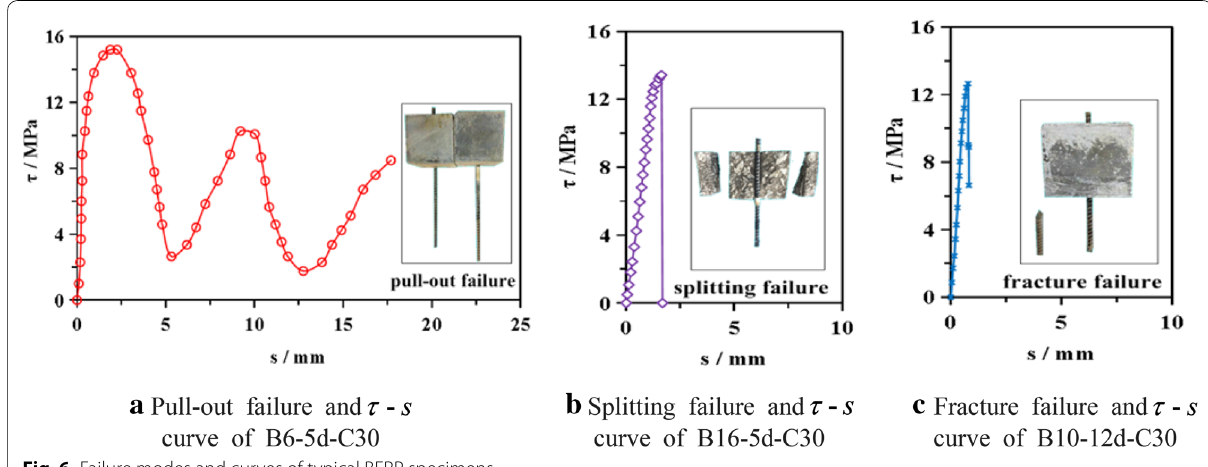
Fig. 6 Failure modes and curves of typical BFRP